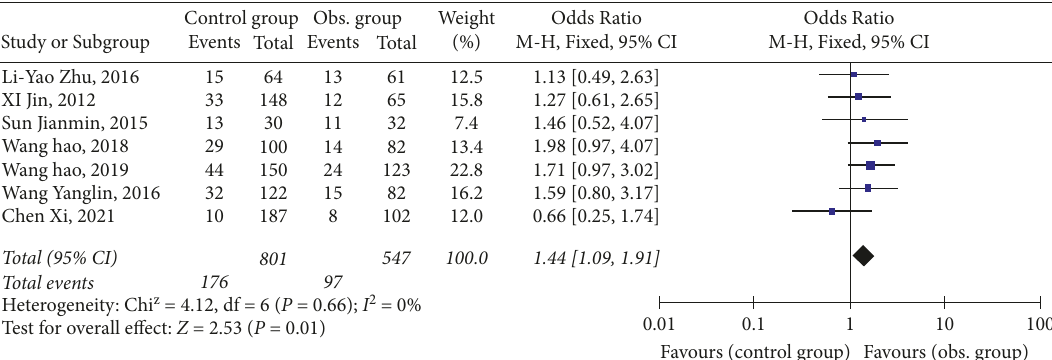
Figure 4: Data of HBeAg negative conversion after 48-week